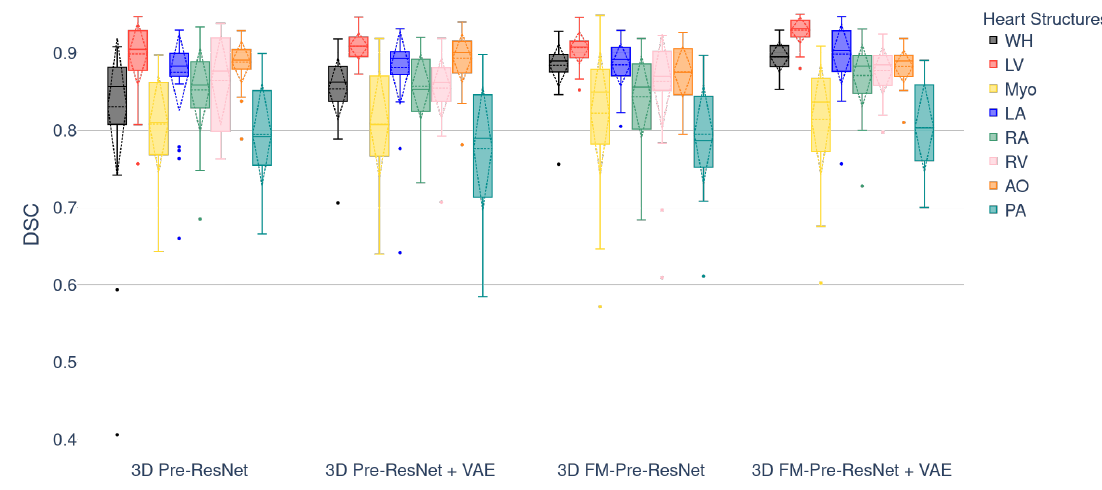
Figure 7. Boxplots showing the DSC dispersion for WH, LV, Myo, LA, RA, RV, AO, and PA using different segmentation networks on the MMWHS MRI testing dataset. Boxplot illustrates interquartile range (bounds of box), mean (X inside a box), median (centerline), maximum and minimum values (whiskers), and outliers (circles outside